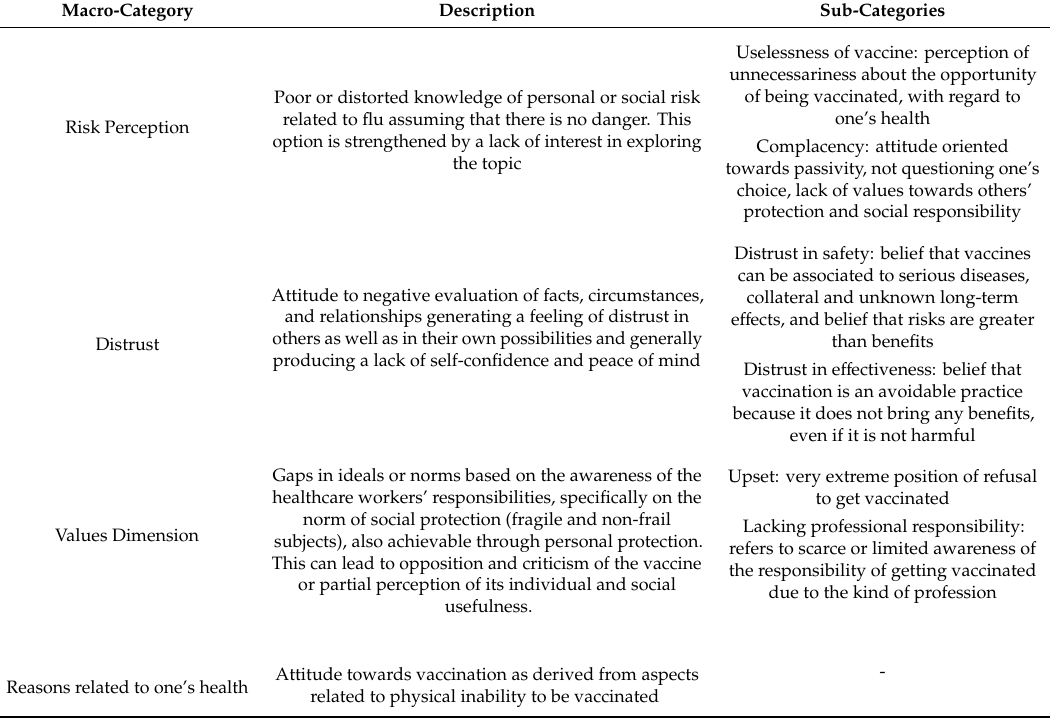
Table 2. Macro-categories and subcategories to not get